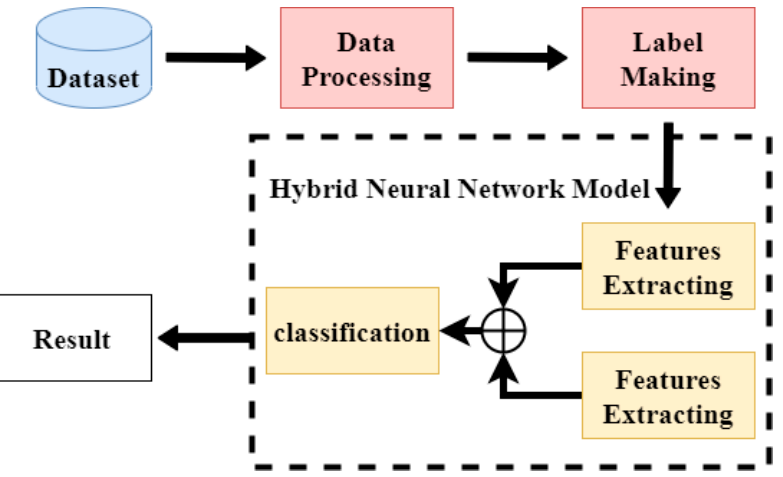
Figure 3. The hybrid model classification process.